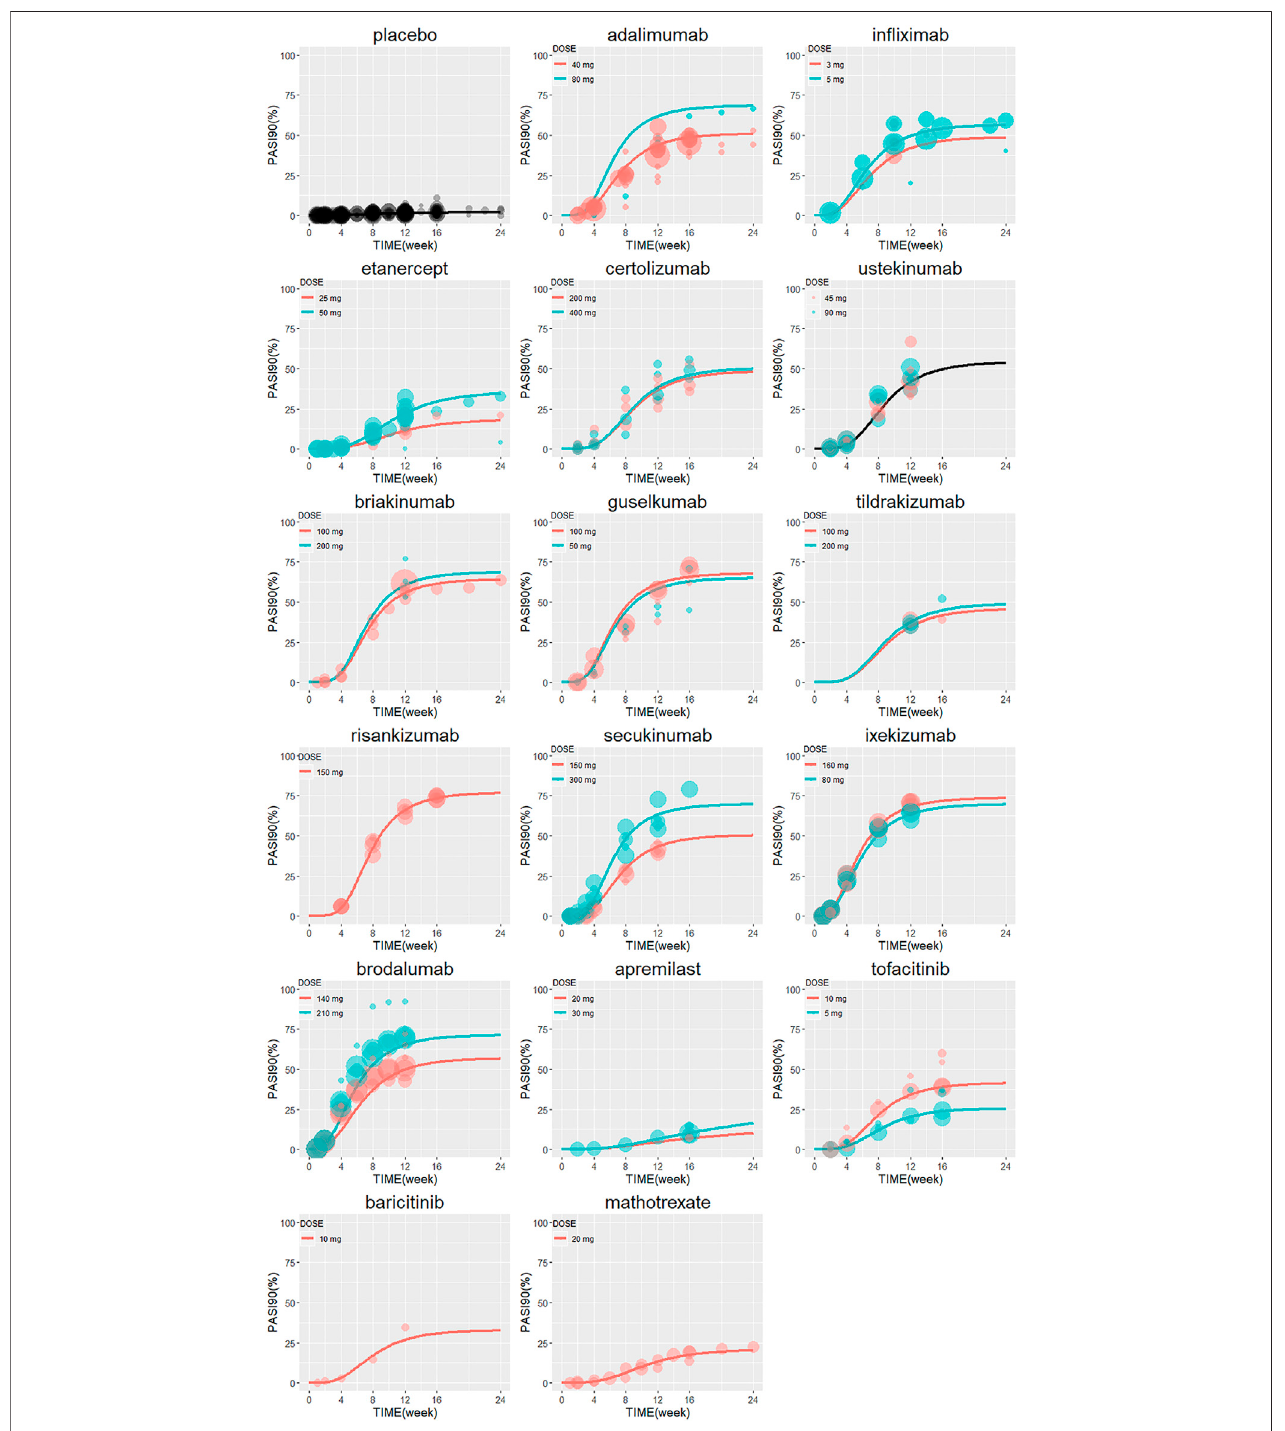
FIGURE 4 | The model predicted typical time course of PASI90 response of each drug. Lines are model predictions for average body weight 90 kg subjects. Circles representtheobservedef fi cacydata,andthesymbolsizeisproportionaltothesamplesize.PASI90, ≥ 90%reductionfrombaselinePsoriasisAreaandSeverityIndexscore.